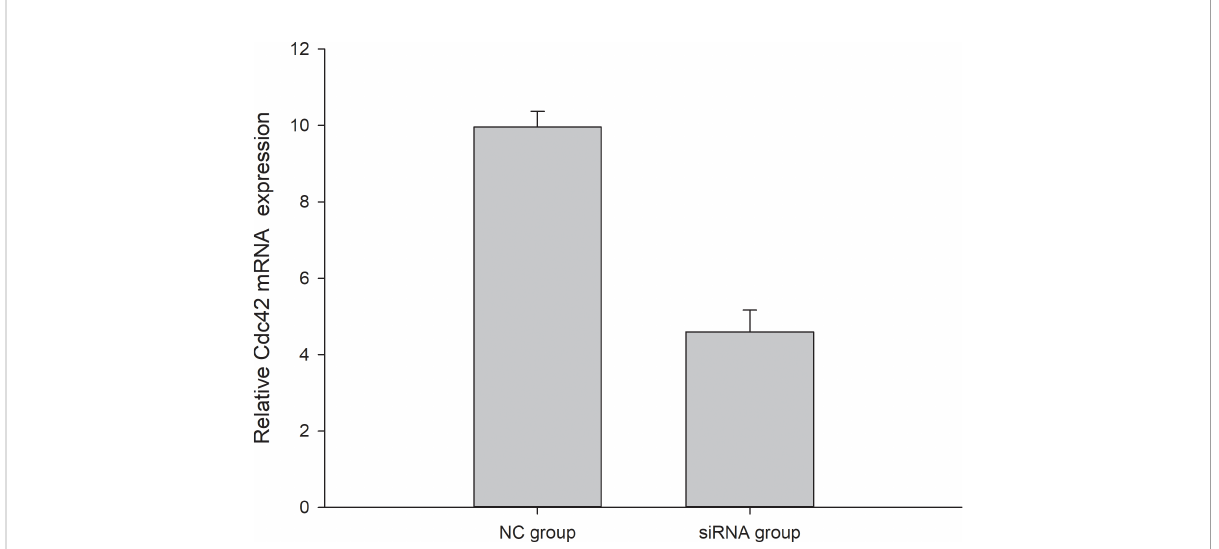
FIGURE 9 The expression of Cdc42 in NC and transfected Drosha -siRNA. NC: Drosha -siRNA-FAM-NC, The siRNA sequence is not present in the fi